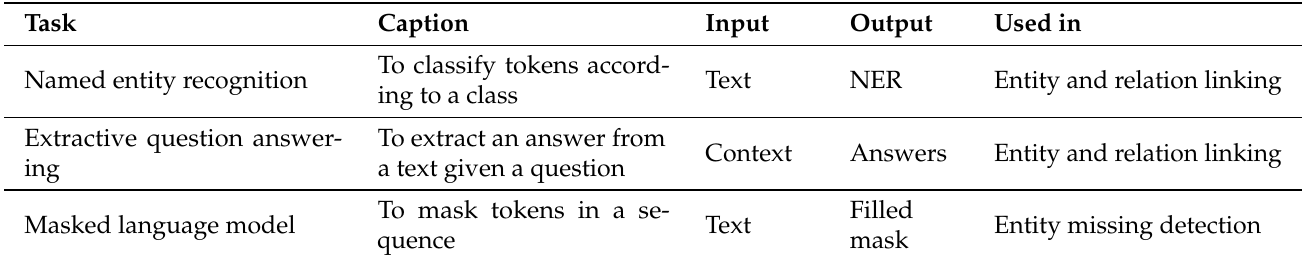
Table 8. Summary of tasks of Transformers [64] that relevant to use for entity and relation linking on KGQA. Task